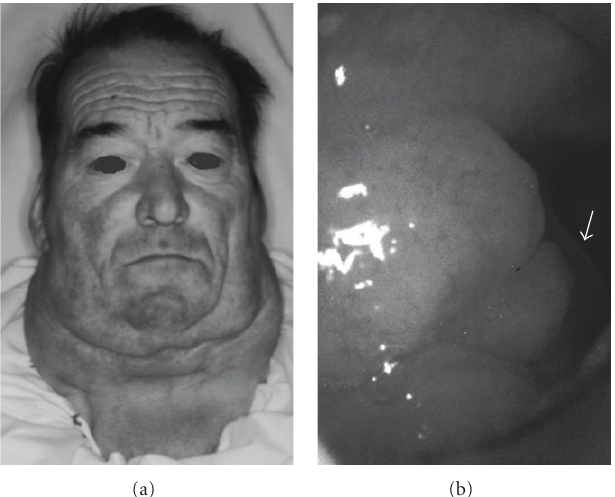
Figure 1: (a) Clinical appearance of subject 1; frontal view with evidence of fatty masses involving parotid region, neck, and upper trunk. (b) laryngoscopic examination revealing fatty infiltration of the left preepiglottic and paralaryngeal space with reduction of the laryngeal vestibular lumen. Left vocal fold (arrow) and glottic space are not involved.